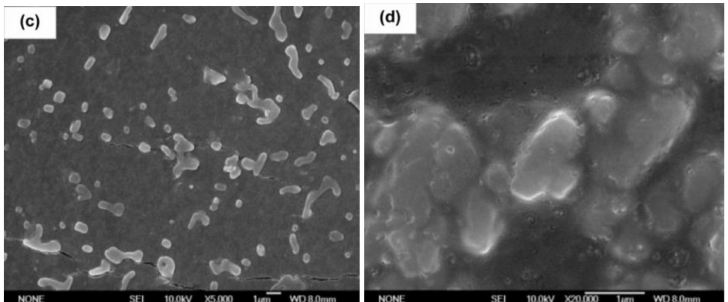
Figure 2. SEM photographs of PE film untreated and treated with D1 and analysis of atom contents on the PE film. ( a ) Changes in the percentage of carbon and oxygen atoms on the PE film surface after a 31-day incubation. ( b ) The control group without D1 bacteria (5000 × ). ( c ) The D1 on the PE surface after 31 days of cultivation under a low magnification lens (5000 × ). ( d ) The D1 on the PE surface after 31 days of cultivation under a high magnification lens (20000 ×